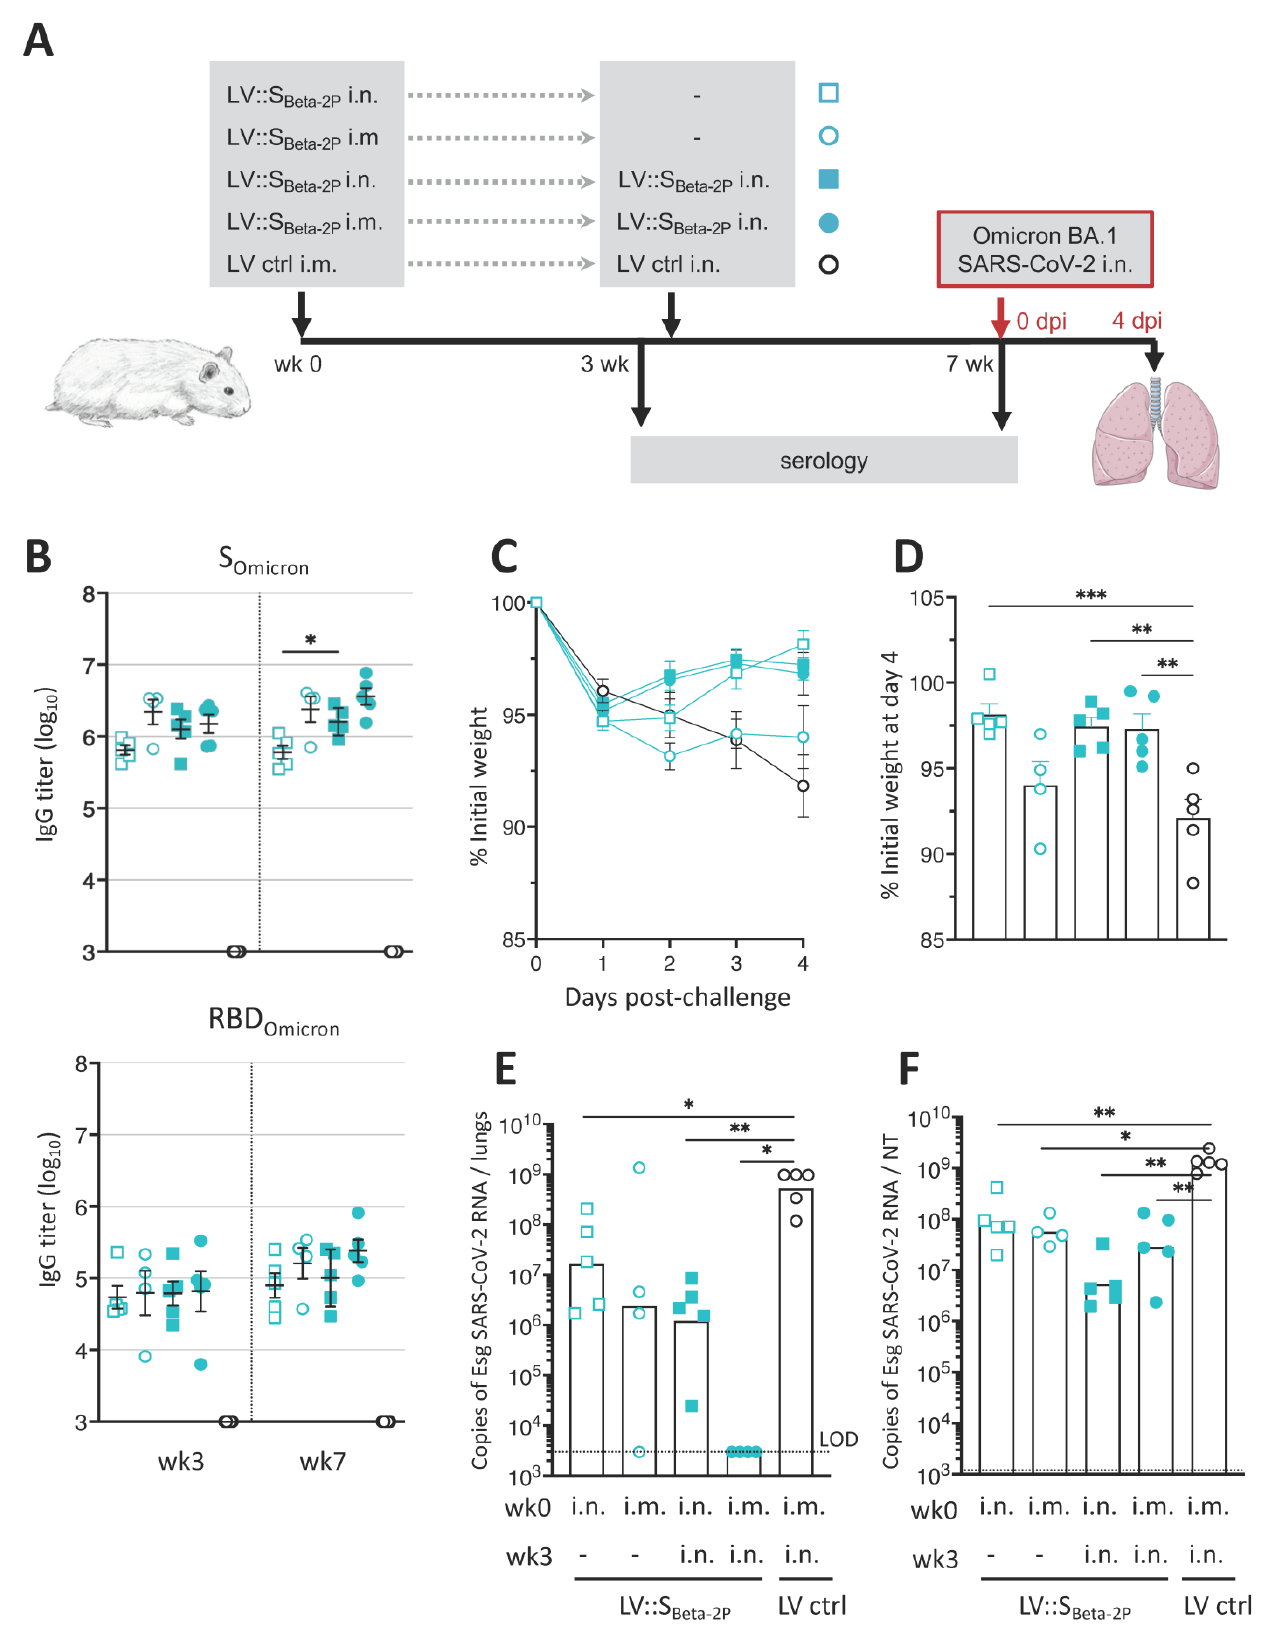
Figure 5. Decreased SARSCoV-2 omicron infectious virus in lungs and nasal turbinates by i.n admin- istration of a single or booster dose of LV::S Beta-2P . ( A ) Timeline of single or prime-boost